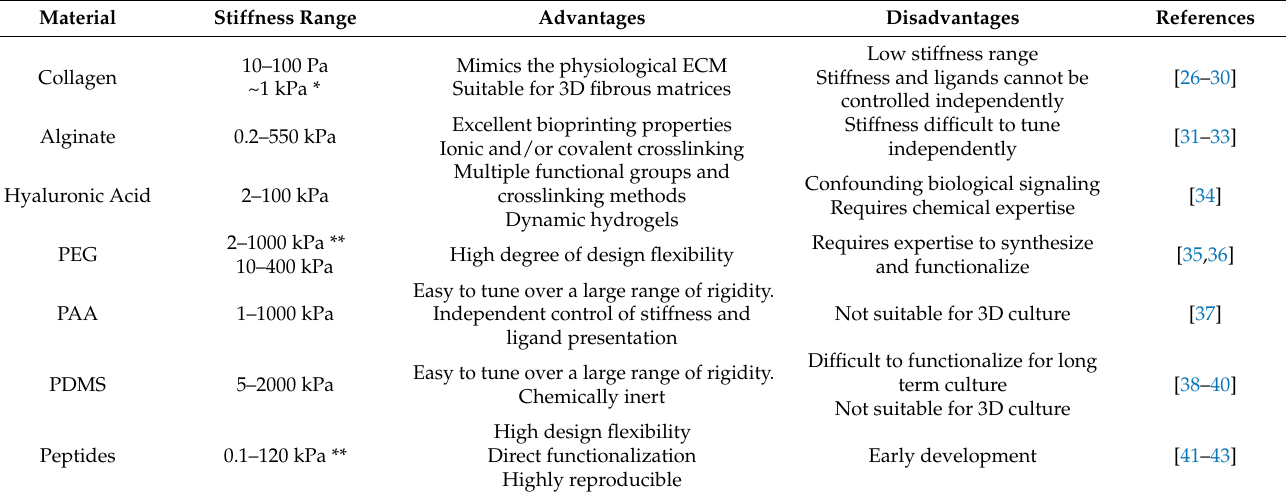
Table 1. Summary of biomaterials for mechanobiology